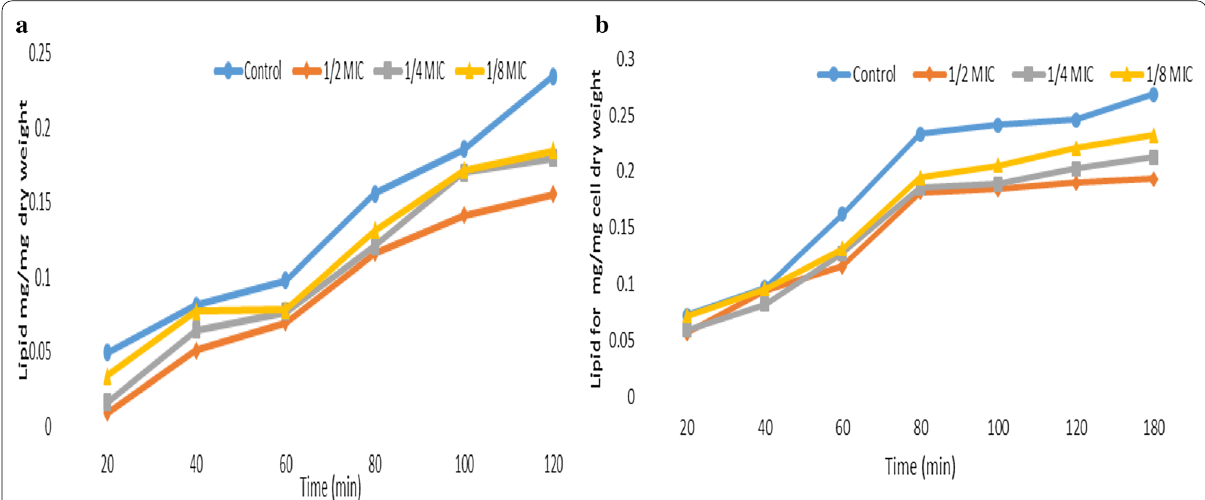
Fig. 2 Effect of different Citrus lemon leaves oil on the total lipids biosynthesis in cells of P. aeruginosa ( a ), S. aureus ( b )